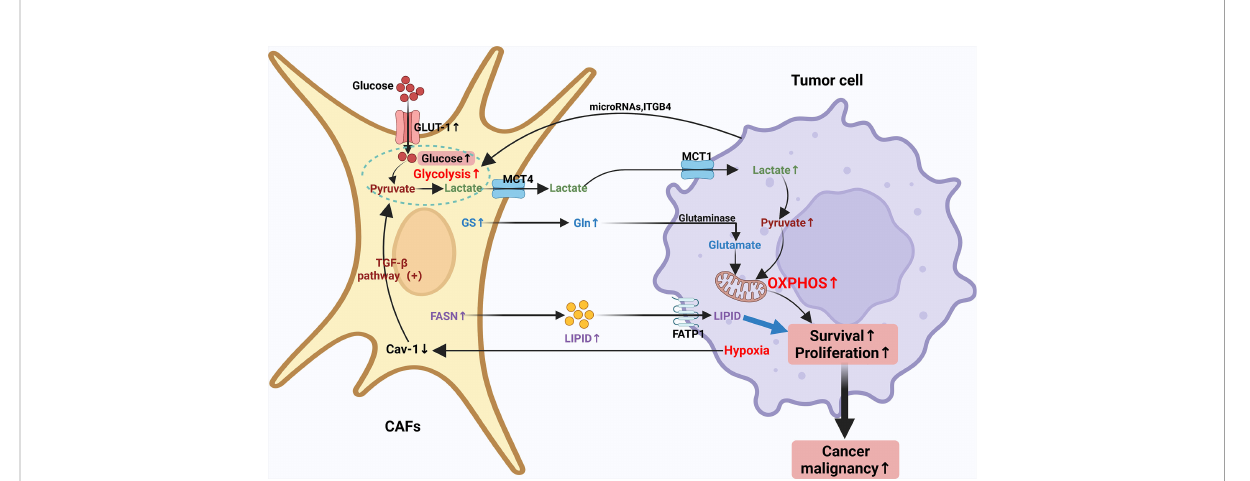
FIGURE 2 Crosstalk of metabolicreprogramming between CAFs and tumor cell. Both cancer cells and CAFs undergoa regulated metabolicreprogramming in the tumor microenvironment,inparticular, CAFs undergo a clear Warburg effect. Typically,tumor cells increase their uptakeofvarious nutrients and enhancetheirmetabolic rate,with glucose and glutamine being the most prominent components. CAFs have been shown tobe involved in the complex metabolism oftumors, mainlyincluding glucose,amino acid and lipid metabolism, prompting tumor cells to counteractenergy depletiondue to the Warburg effect. The regulation ofCAFs through these metabolicswitches forms a unique CAF behavior and leads to altered tumor cellbehavior throughthe unique regulationof CAFs throughthese metabolic